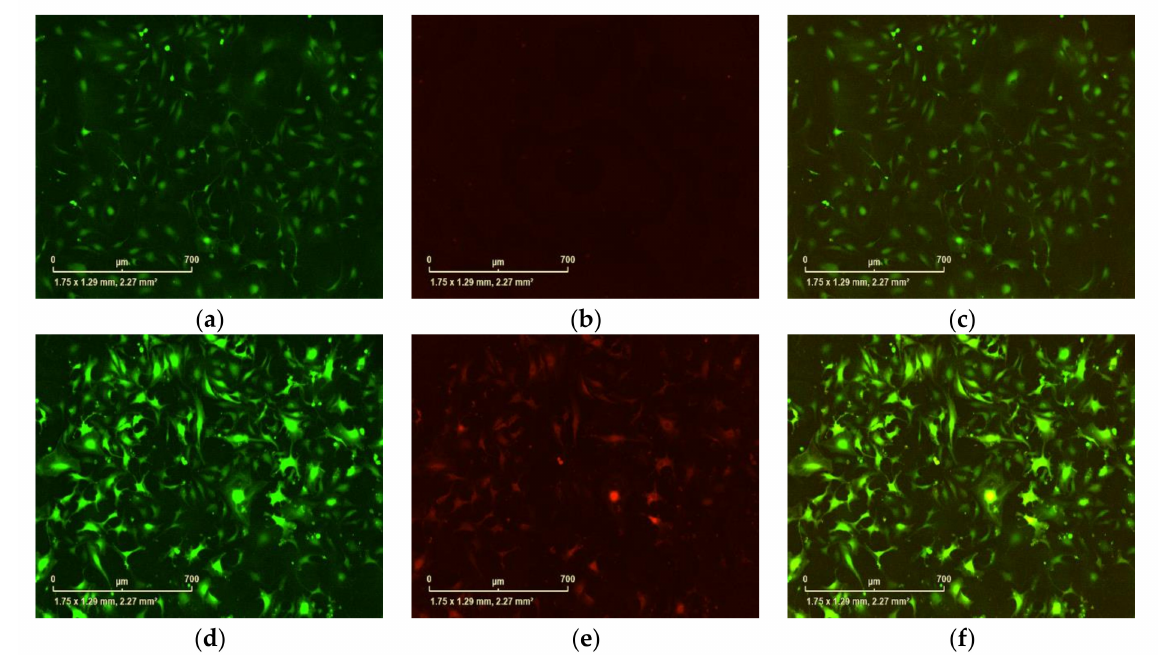
Figure 15. Validation of Tet-off TurboFP635 expression System. N2C-pTet-TurboFP635-EF-1a-eGFP 3A4 cells without transfect with tTA_BFP plasmid (( a – c ), scale bar = 0.7 mm). ( a ) eGFP detection, ( b ) TurboFP635 detection, ( c ) Overlap of green and red fluorescence image; N2C-pTet-Turbo-eGFP 3A4 cells transfect with tTA_BFP plasmid (( d – f ), scale bar = 0.7 mm). ( d ) eGFP detection, ( e ) TurboFP635 detection, ( f ) overlap of green and red fluorescence